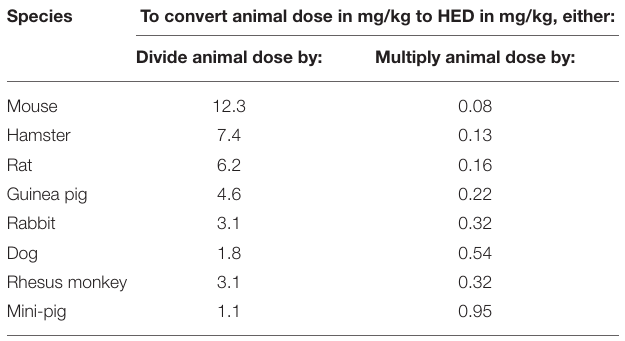
TABLE 1 | Converting preclinical supplement doses to human equivalent doses (HED). Species To convert animal dose in mg/kg to HED in mg/kg, either: Divide animal dose